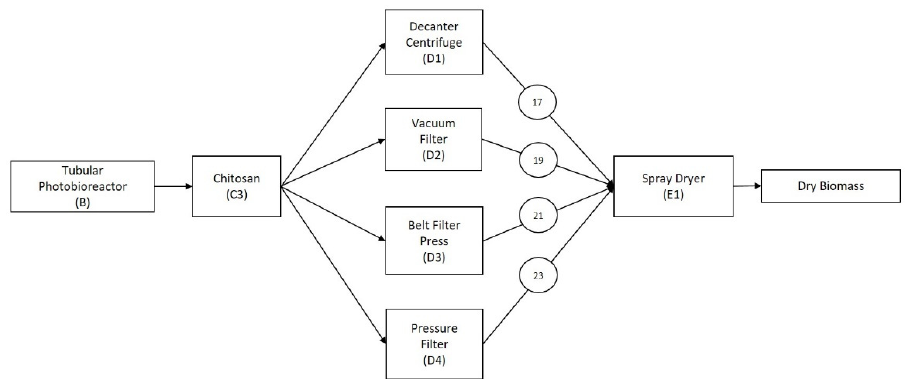
Figure 10. Scenarios for the production of high-quality biomass (harvested with Chitosan).